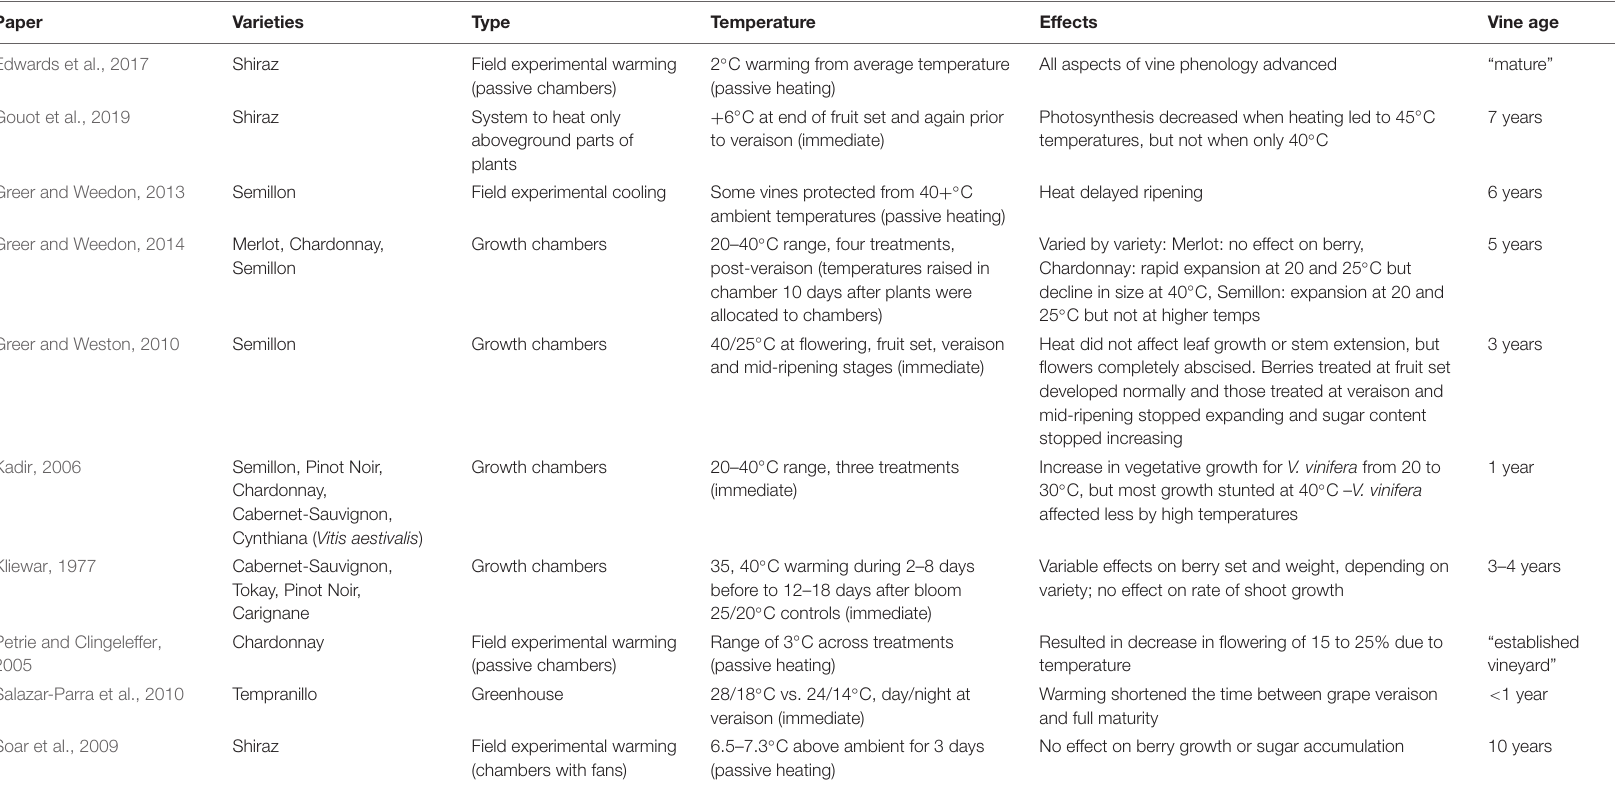
TABLE 1 | Literature review of studies applying experimental warming to winegrapes during development and following phenological responses.